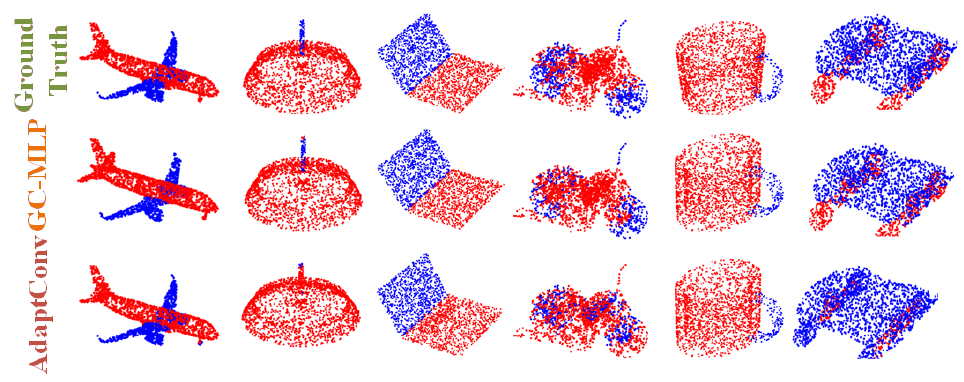
Figure 3. Visualization of shape part segmentation results on ShapeNet Parts. The first row is the ground truth, and the second row is the predictions of our GC-MLP. From left to right are the airplane, chair, earphone, lamp, laptop, motorbike, mug and skateboard.